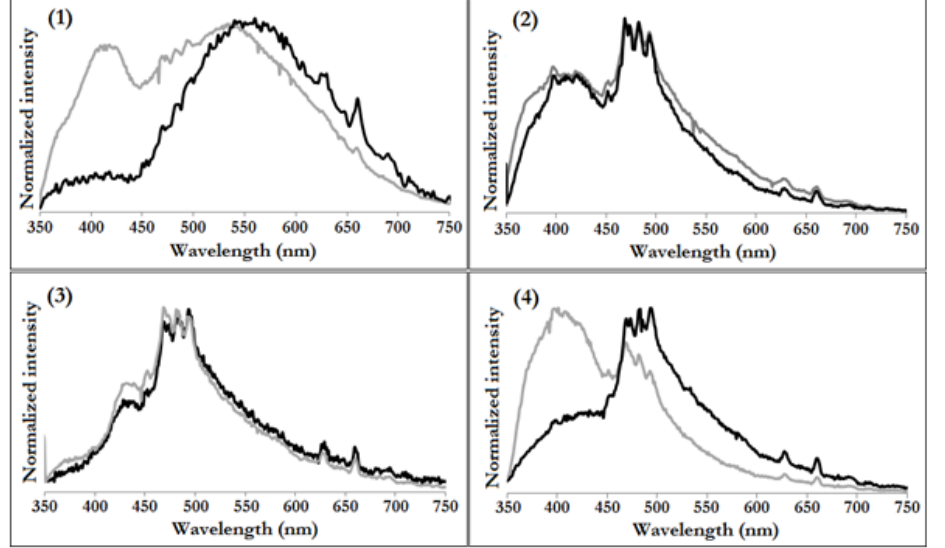
Figure 3. Solid state photoluminescence spectra (1–4) of (Ti 4 O 2 (O i Bu) 10 (O 2 CR’) 2 ) (R’ = C 13 H 9 ( 1 ), PhCl ( 2 ), PhNO 2 ( 3 ), PhNH 2 ( 4 )) respectively (black plots) collected by 330 nm excitation at room temperature compared to spectra of corresponding acids (grey plots).